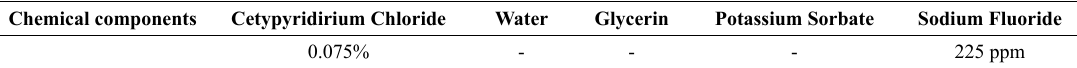
Table 1. Mouthwash chemical composition (Plax, Colgate Palmolive Industrial Ltda, São Paulo,